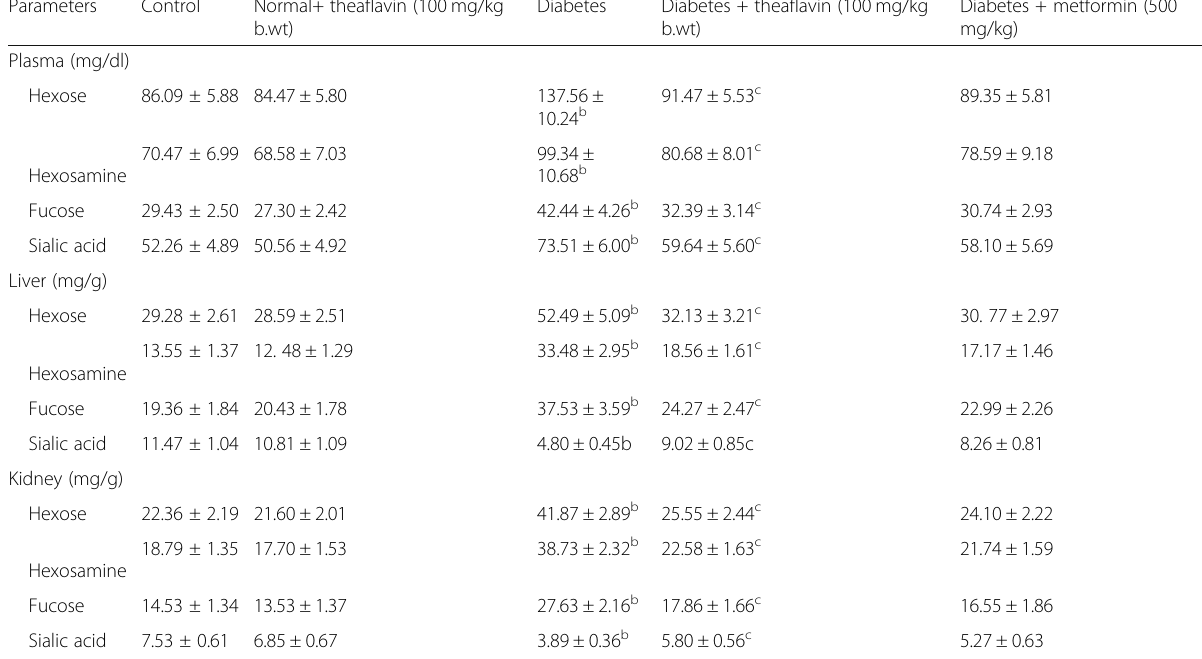
Table 3 Effects of theaflavin on glycoprotein metabolism in control and experimental animals Parameters